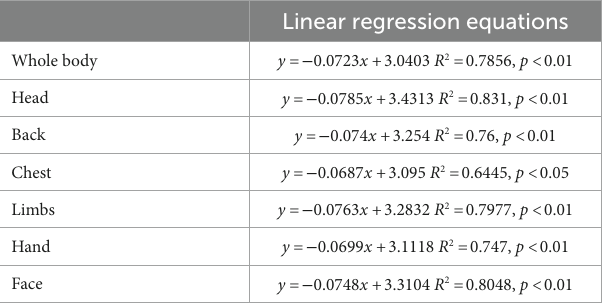
TABLE 5 Results of linear regression equations for Δ MTSV against T a . Linear regression equations